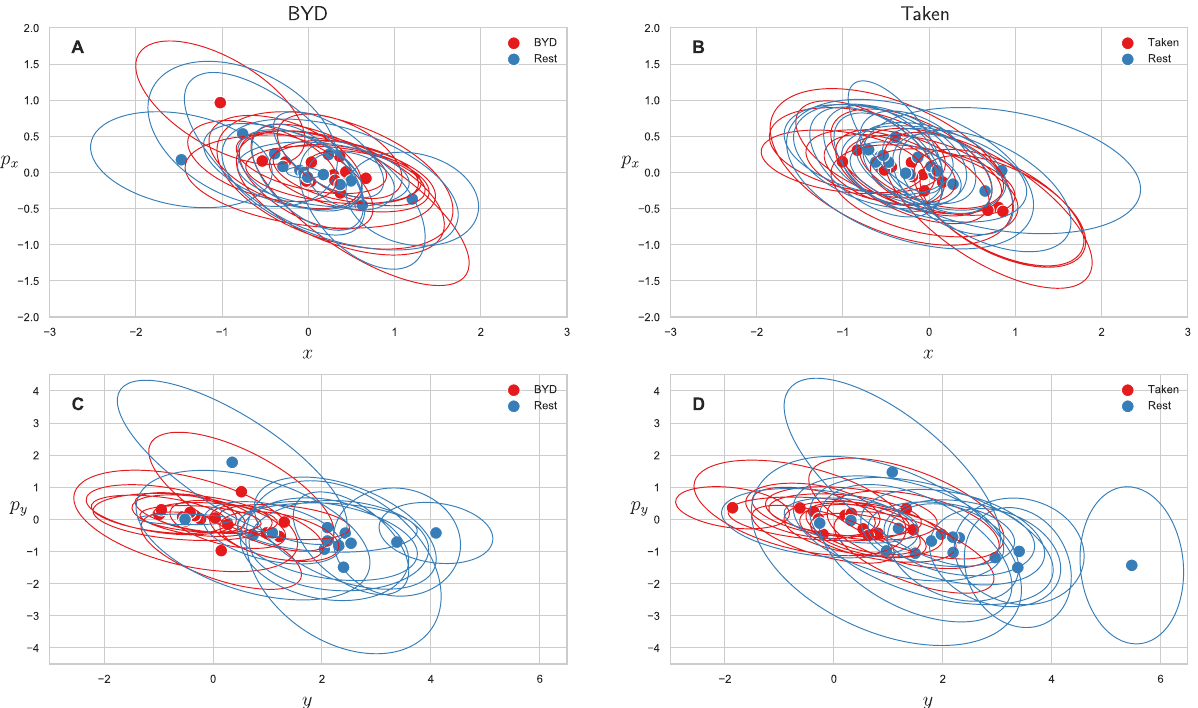
Figure 2. Mean phase space centroids for each subject. Ellipses represent the 1 standard deviation confidence interval. Centroids for the scrambled stimuli were omitted as they are indistinguishable from intact stimuli ( P > 0.85) ( A ) Centroids for “Bang! You’re Dead” along the x direction. ( B ) Centroids for “Taken” along the x direction. ( C ) Centroids for “Bang! You’re Dead” along the y direction. ( D ) Centroids for “Taken” along the y direction. Differences are only apparent in the y direction ( P < 0.001, Tukey adjusted) indicative of the higher level of anterior activation as noted in Fig.